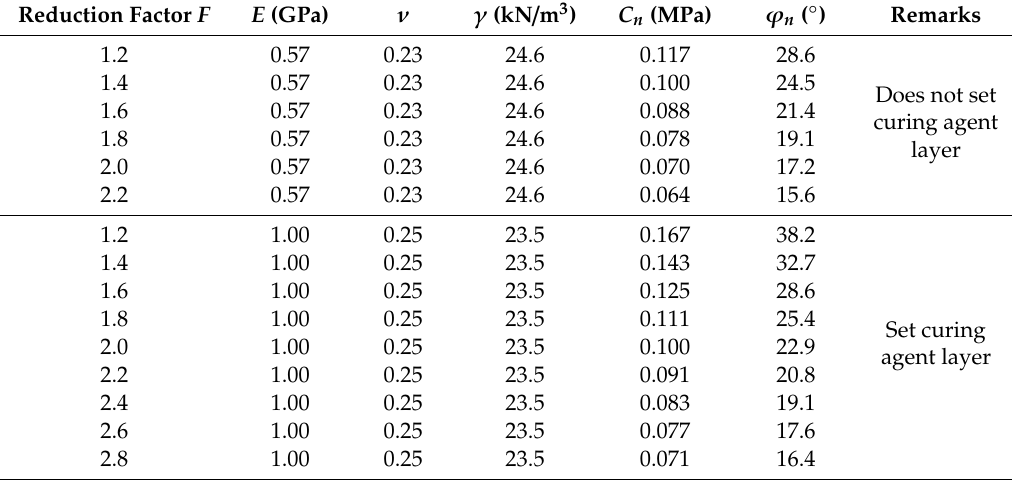
Table 2. Parameter values of geotechnical materials under di ff erent reduction coe ffi cients.